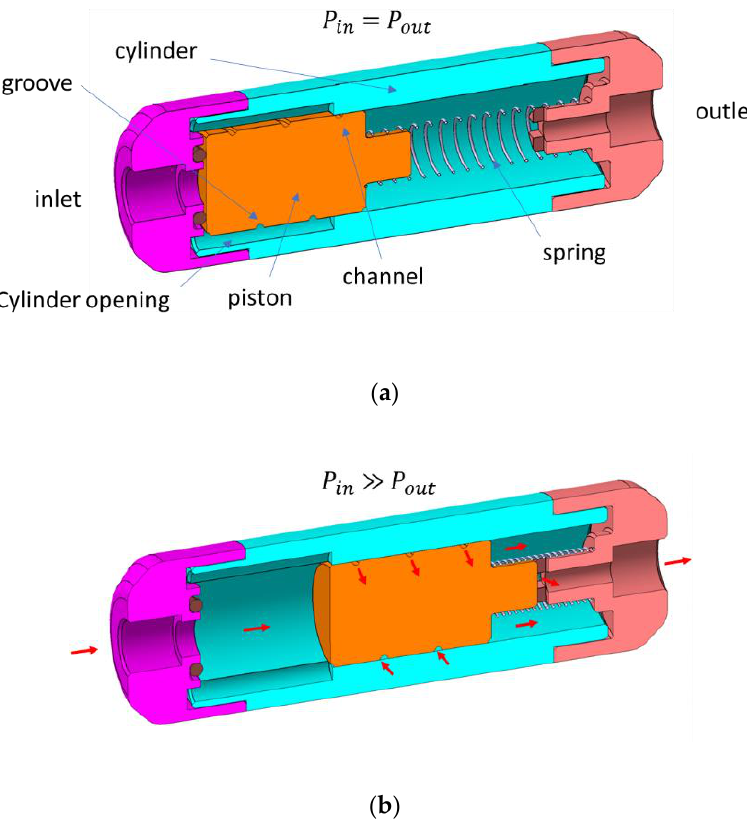
Figure 12. Schematic drawings of a constant flow regulating spring valve. ( a ) Device at rest. A small part of the piston groove is engaged into the narrow part of the cylinder to form a fluidic channel. ( b ) Device submitted to a large pressure P in ≫ P out . As the inlet pressure increases, the piston moves along the cylinder and the channel length increases as well. At large pressure, the piston is stopped and the hydraulic resistance of the device becomes constant.